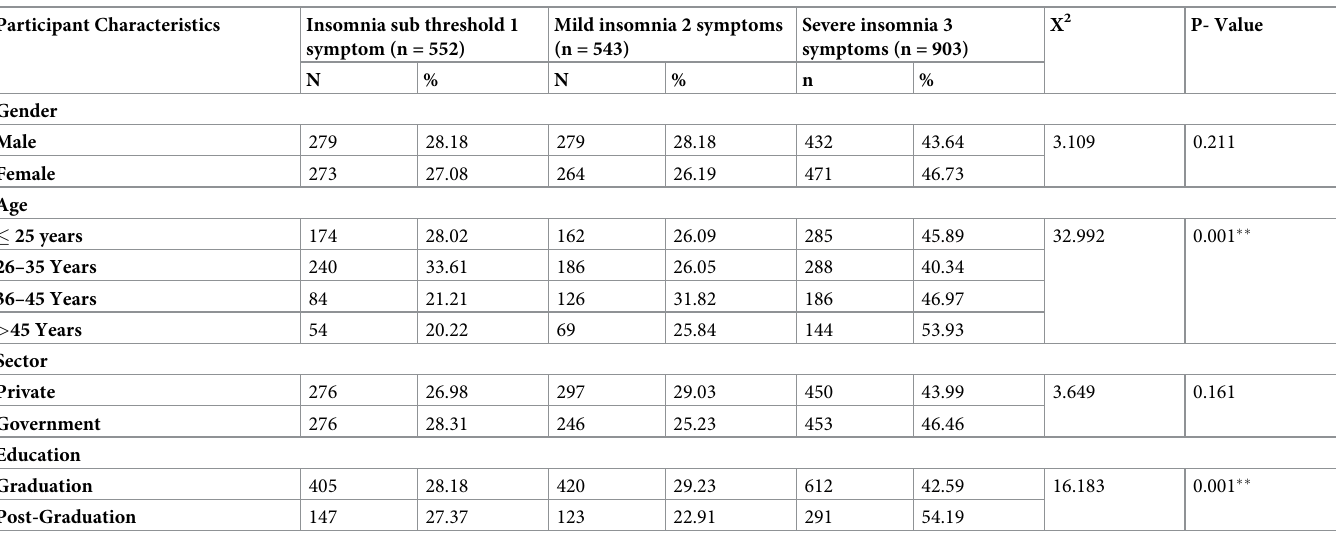
Table 4. Symptoms and prevalence of insomnia.